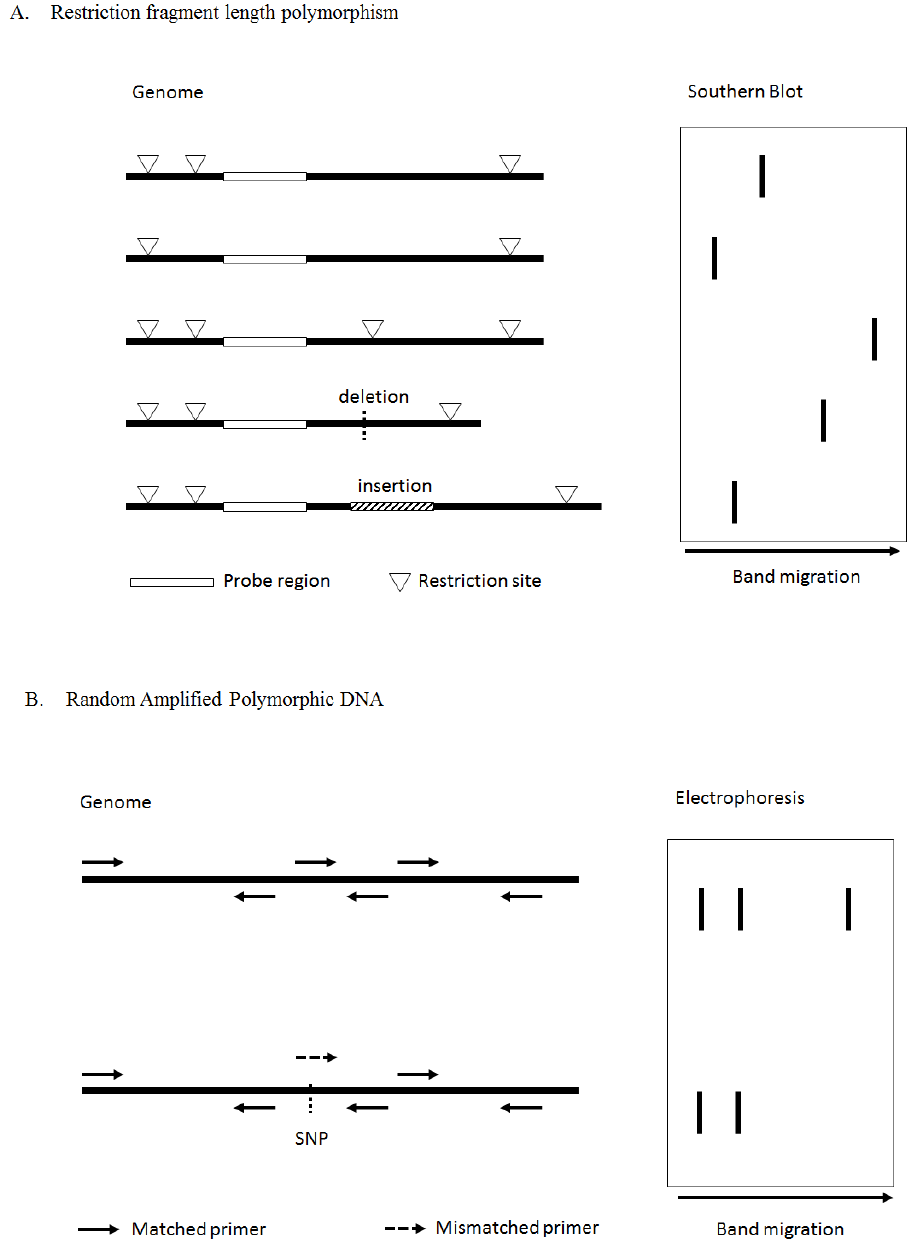
Figure 3. Principles of Restriction Fragment Length Polymorphisms ( A ) and Random amplified polymorphic DNA ( B ). The resulting fragments from target genome DNA are generated ( left ) and separated by gel electrophoresis followed by appropriate detection approach ( right ). To perform restriction fragment length polymorphisms (RFLP), genome DNA from variant individuals are subject to restriction digest (restriction sites are indicated by triangle) and random genomic probe (complement sequences are indicated by empty rectangle) is used for Southern Blot detection. Bands shown in Southern Blot represent (1) wild type; (2) loss of restriction site; (3) gain restriction site; (4) deletion of DNA fragment; (5) insertion of DNA fragment, from top to bottom. To perform RAPD, random primer sets are used to amplify genome DNA. Each matched primer set (full line arrow) generates a specific size product that appears in both wild type ( top ) and mutant ( bottom ) genome. Meanwhile mismatched primer (dashed line arrow) causes band absent in